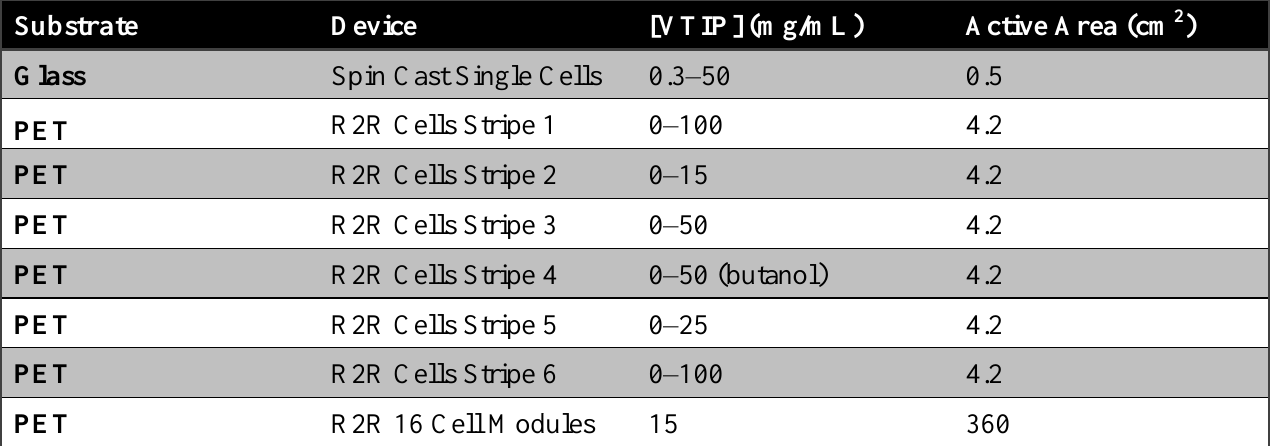
Table 2. Summary of cells used in this study, each line represents ̴ 50 devices (400